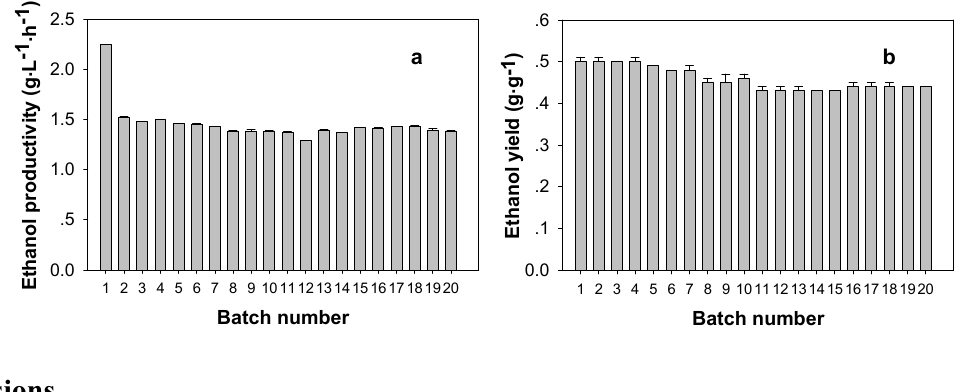
Figure 5. Ethanol production efficiencies of repeated-batch fermentation from sweet sorghum juice containing 240 g·L − 1 of total sugar and 21 g·L − 1 of DSY (dried spent yeast) by S . cerevisiae NP01. ( a ) ethanol productivity; ( b ) ethanol yield.